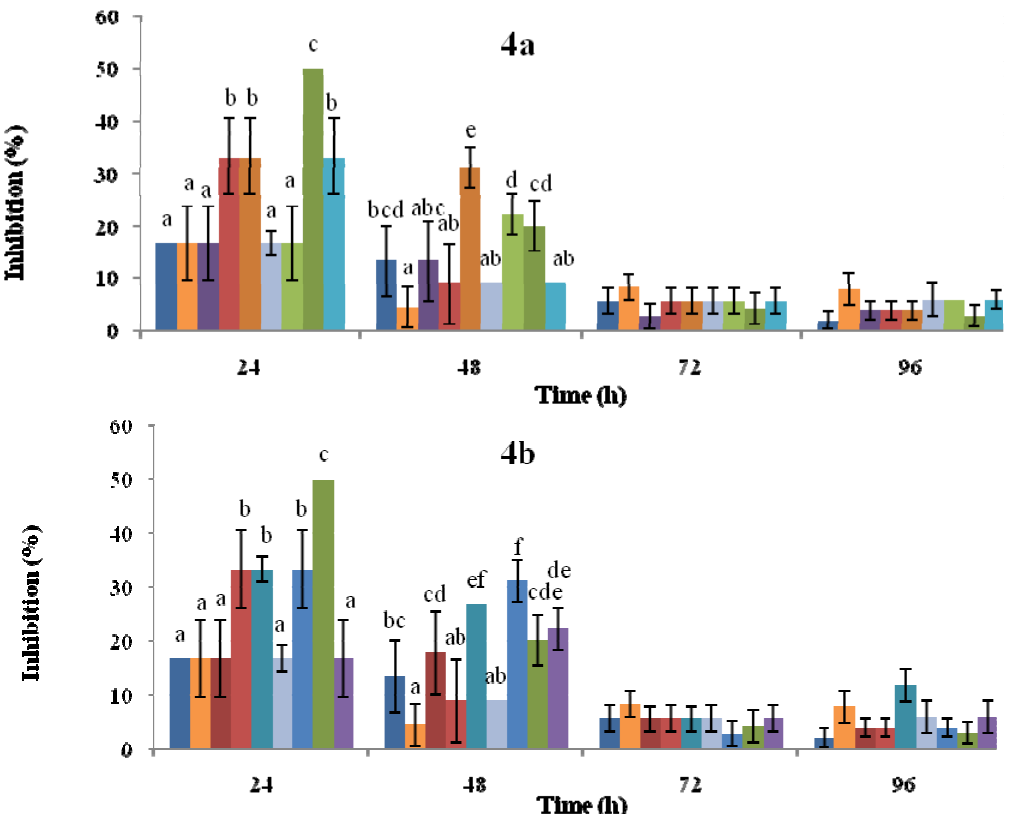
Figure 4. Antifungal activity against C. lindemuthianum of extracts from common bean cotyledons induced by SA at different concentration (up) and post-induction time